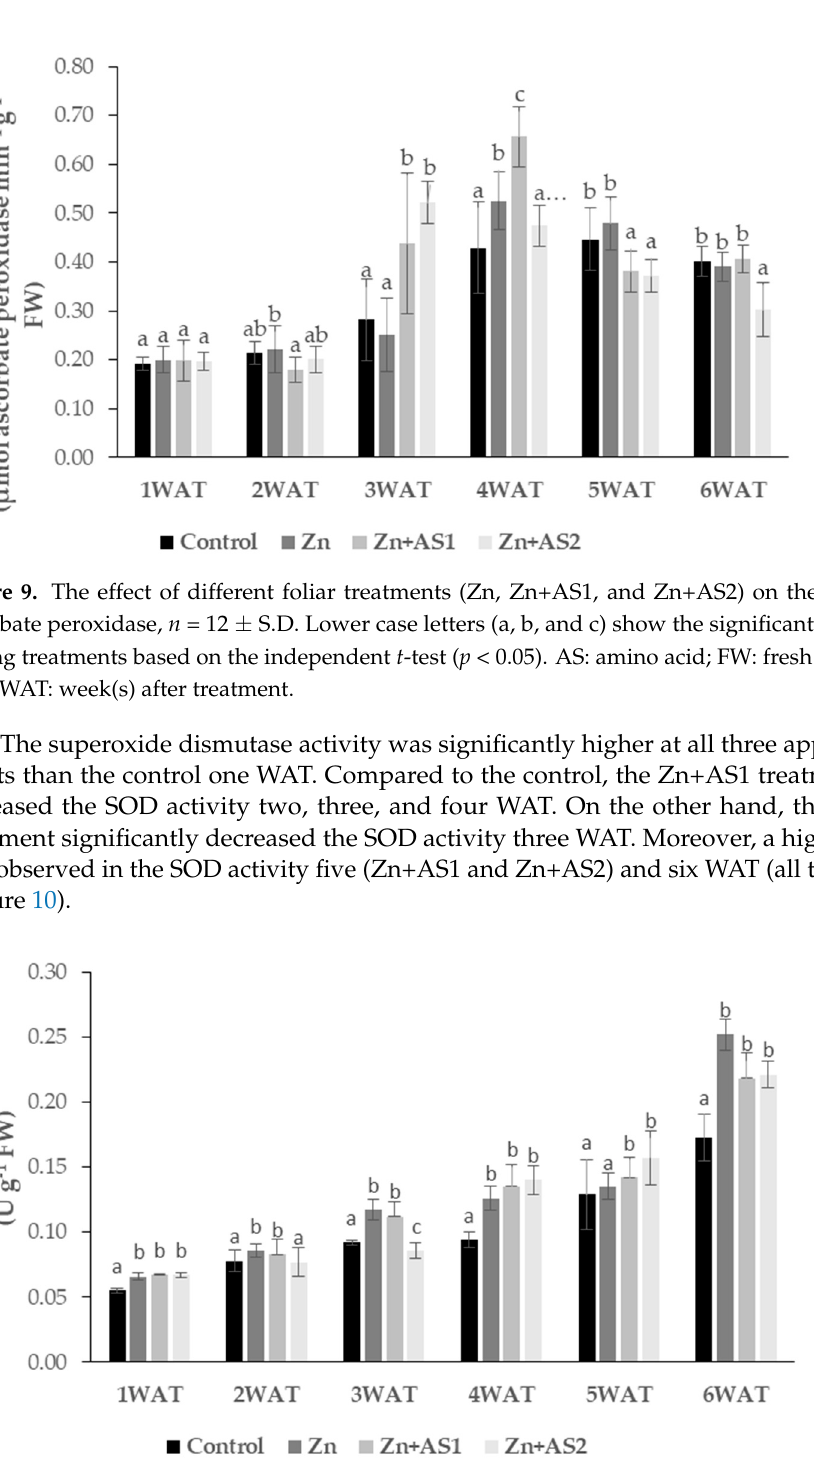
Figure 10. The effect of different foliar treatments (Zn, Zn+AS1, and Zn+AS2) on the activity of superoxide dismutase, n = 12 ± S.D. Lower case letters (a, b) show the significant differences among treatments based on the independent t -test ( p < 0.05). AS: amino acid; FW: fresh weight; Zn: zinc; WAT: week(s) after